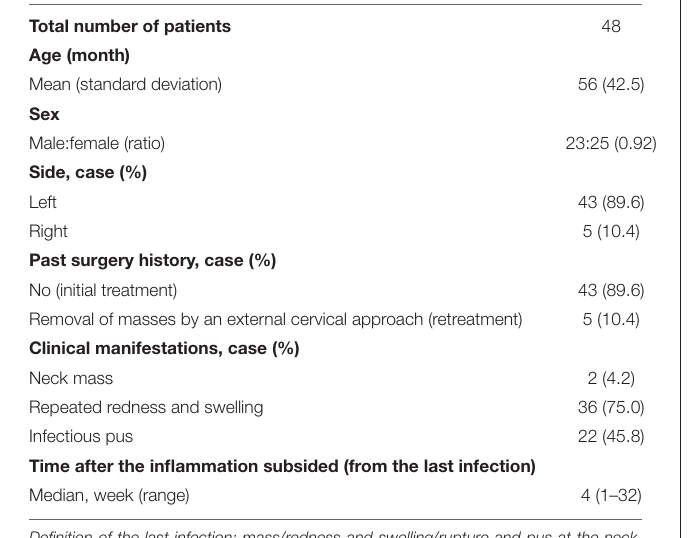
TABLE 1 | Demographic and clinical characteristics.